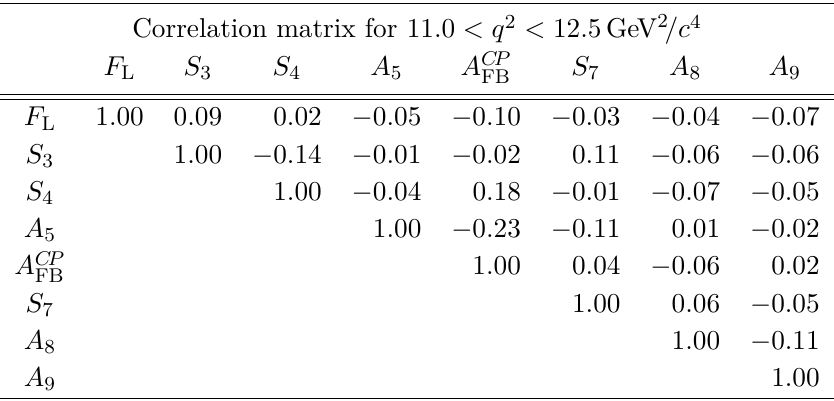
Table 4 . Correlation matrix for the q 2 regions 4 . 0 < q 2 < 6 . 0 GeV 2 /c 4 , 6 . 0 < q 2 < 8 . 0 GeV 2 /c 4 and 11 . 0 < q 2 < 12 . 5 GeV 2 /c 4